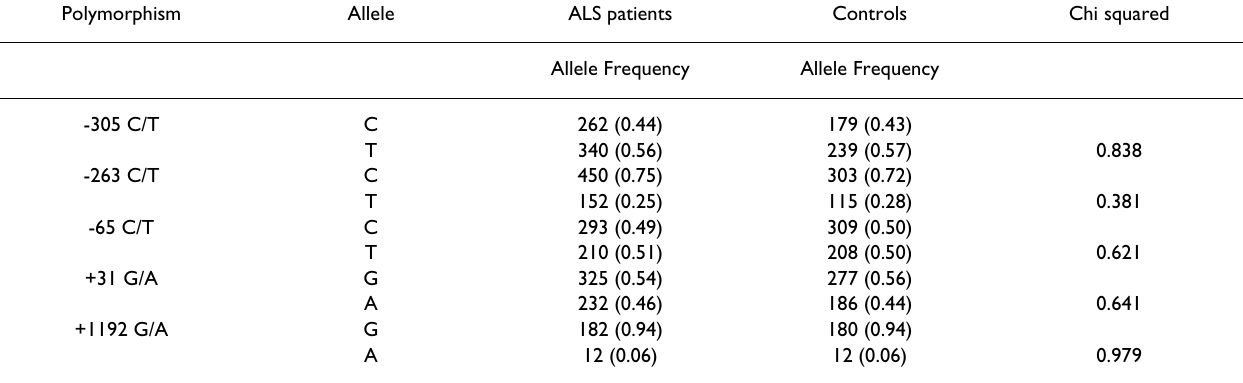
Table 2: Frequencies of polymorphisms in the regulatory regions and exon 7 in ALS and control populations